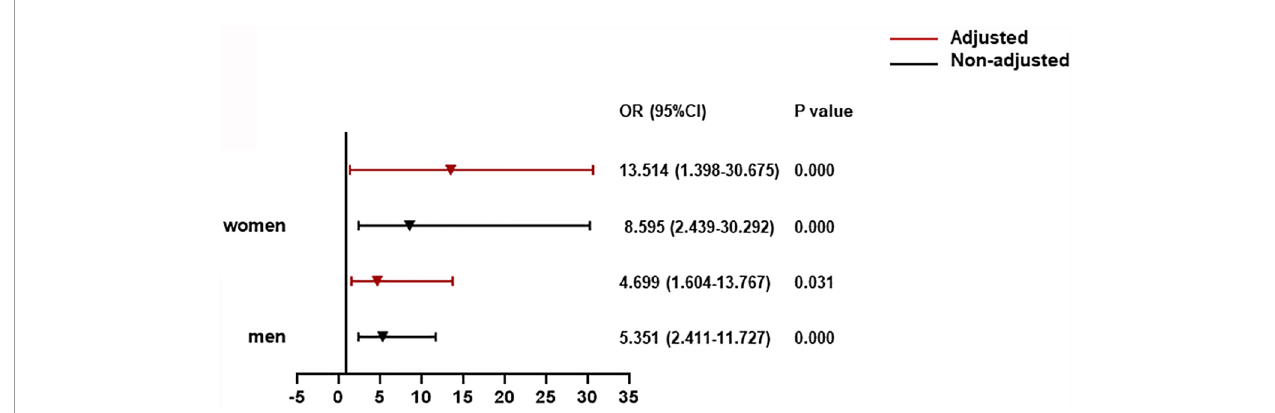
FIGURE 4 | The association between CysC rangeability and all-cause death in T2DM patients. CysC rangeability (changes in renal function) calculated as the difference in the CysC level between the time of hospital admission and the highest CysC level recorded during hospitalization. Adjusted by age, severe pneumonia, serum albumin, blood glucose, log NT-proBNP baseline. T2DM, type 2 diabetes mellitus; NT-proBNP, N terminal pro B type natriuretic